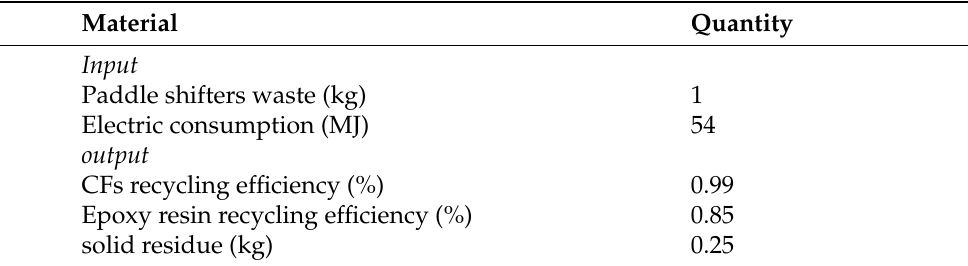
Table 8. Inventory data for CO 2 -assisted pyrolysis of the paddle shifters. The CO 2 was not included in the mass balance since it is recirculated in the process. CO 2 losses were not considered. The data are valid both for CFRP-ff and CFRP-bio. Data of electricity consumption were taken from Nunes et al.